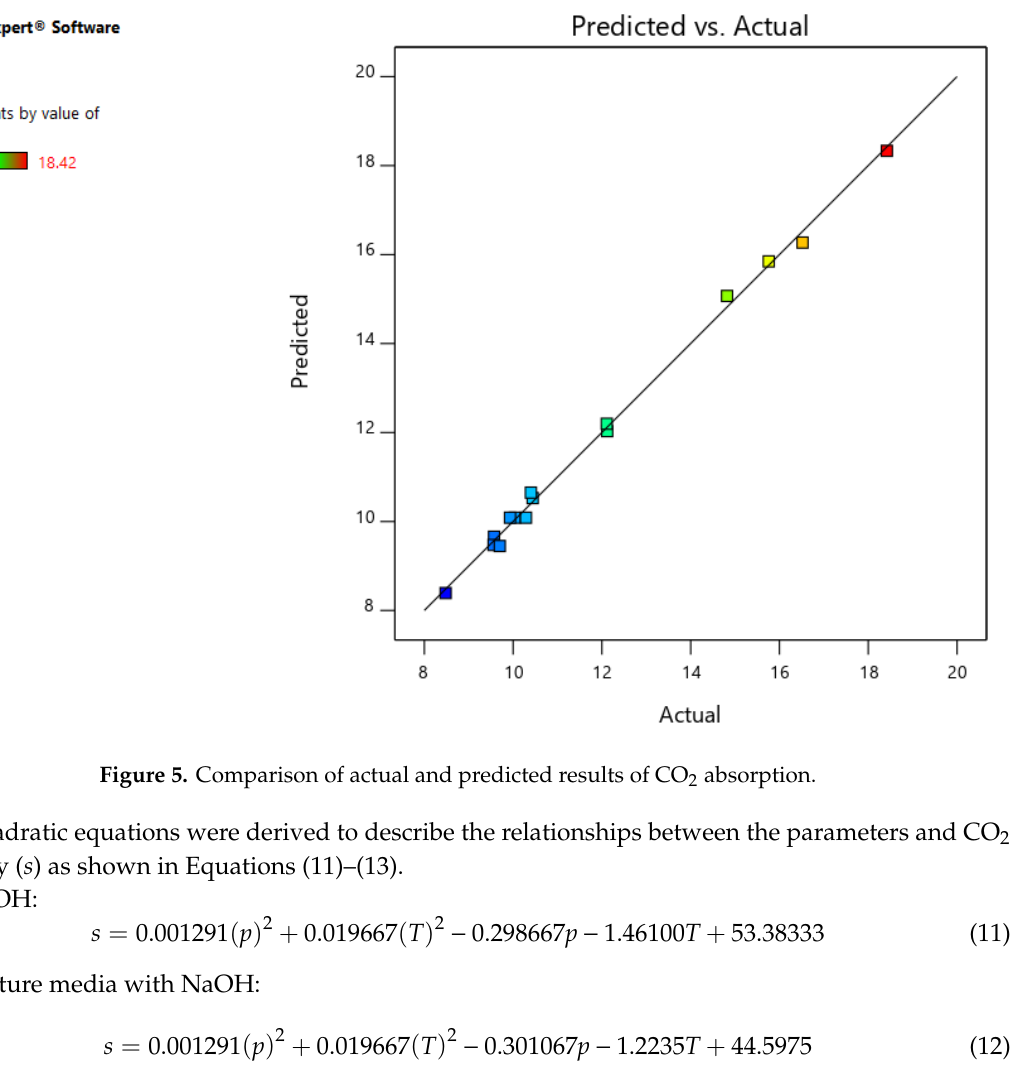
solubility ( s ) as shown in Equations (11)–(13).